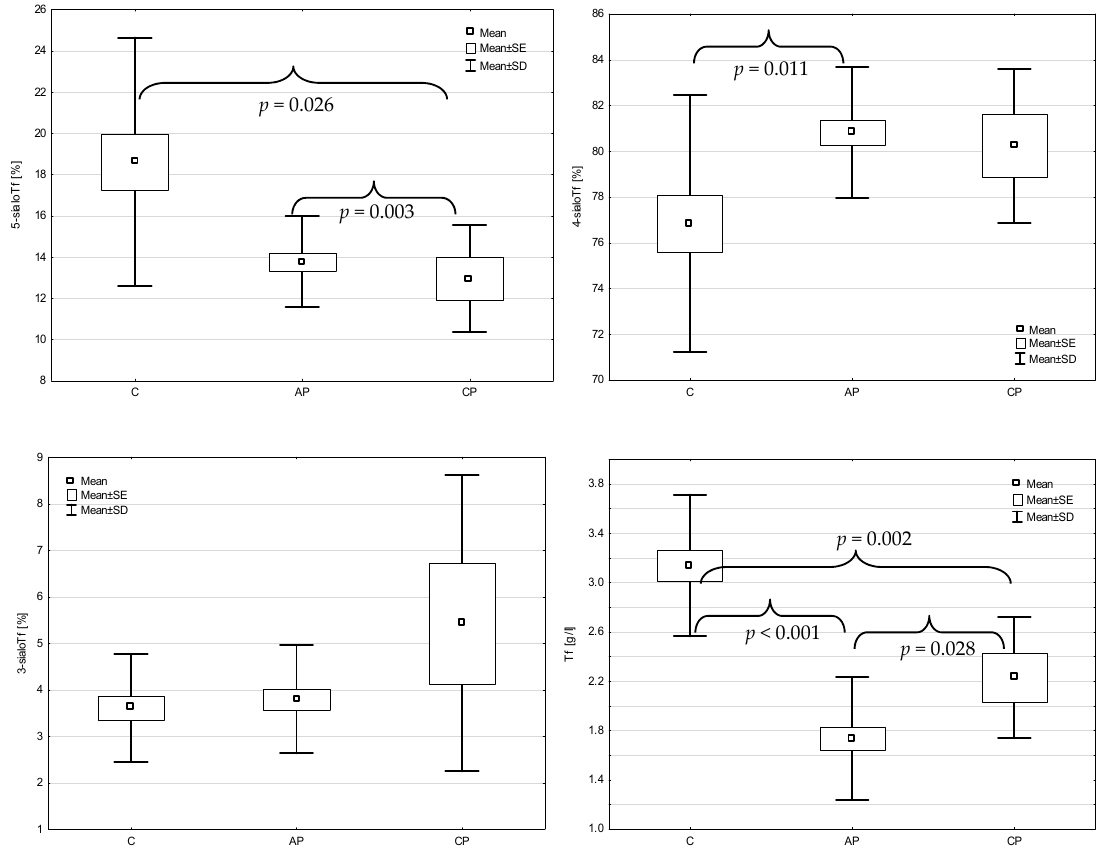
Figure 1. The concentrations of transferrin isoforms and total transferrin in the control (C), acute pancreatitis (AP) and chronic pancreatitis (CP) groups.